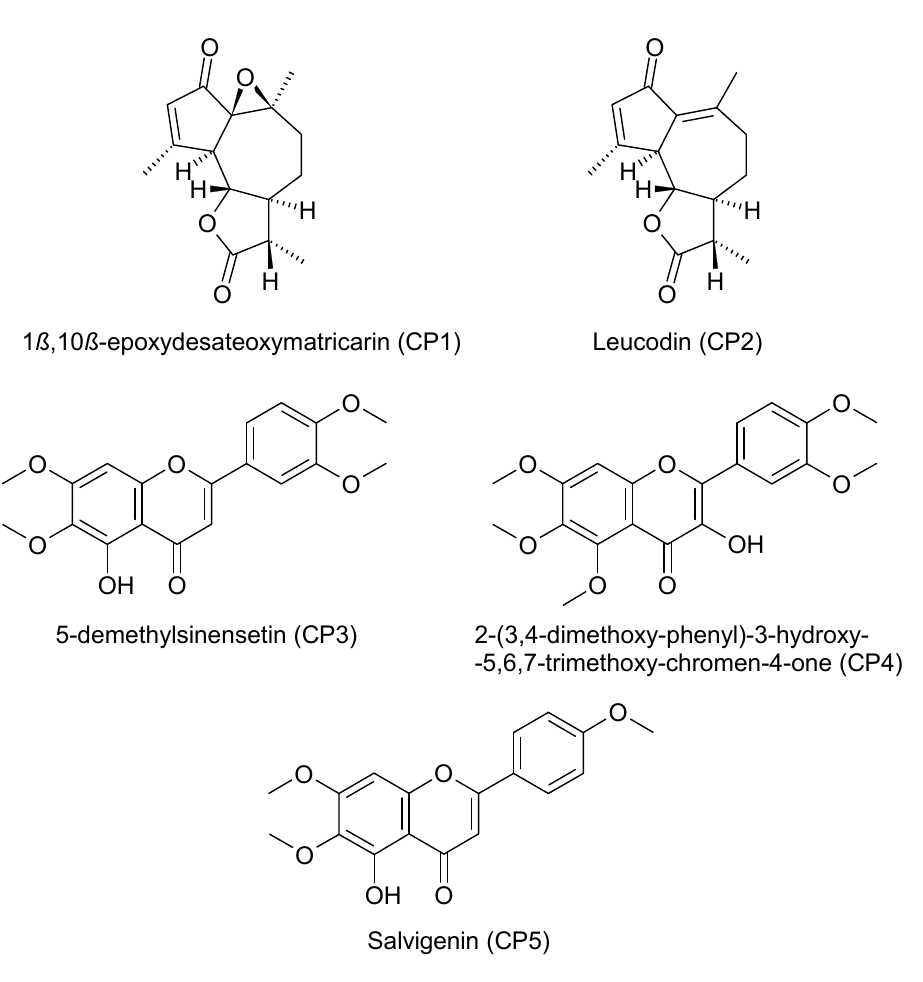
Figure 6. The structures of the compounds isolated and identified from the CF of A. wilhelmsii. The total content of polyphenols was determined by a modified Folin-Ciocalteu colorimetric method, and the results were expressed as gallic acid equivalent (GAE) per gram of dry extract weight. Flavone and flavonol contents were analyzed using a colorimetric method, and the results were expressed as quercetin equivalent (QE) per gram of dry extract weight [25]. The findings are